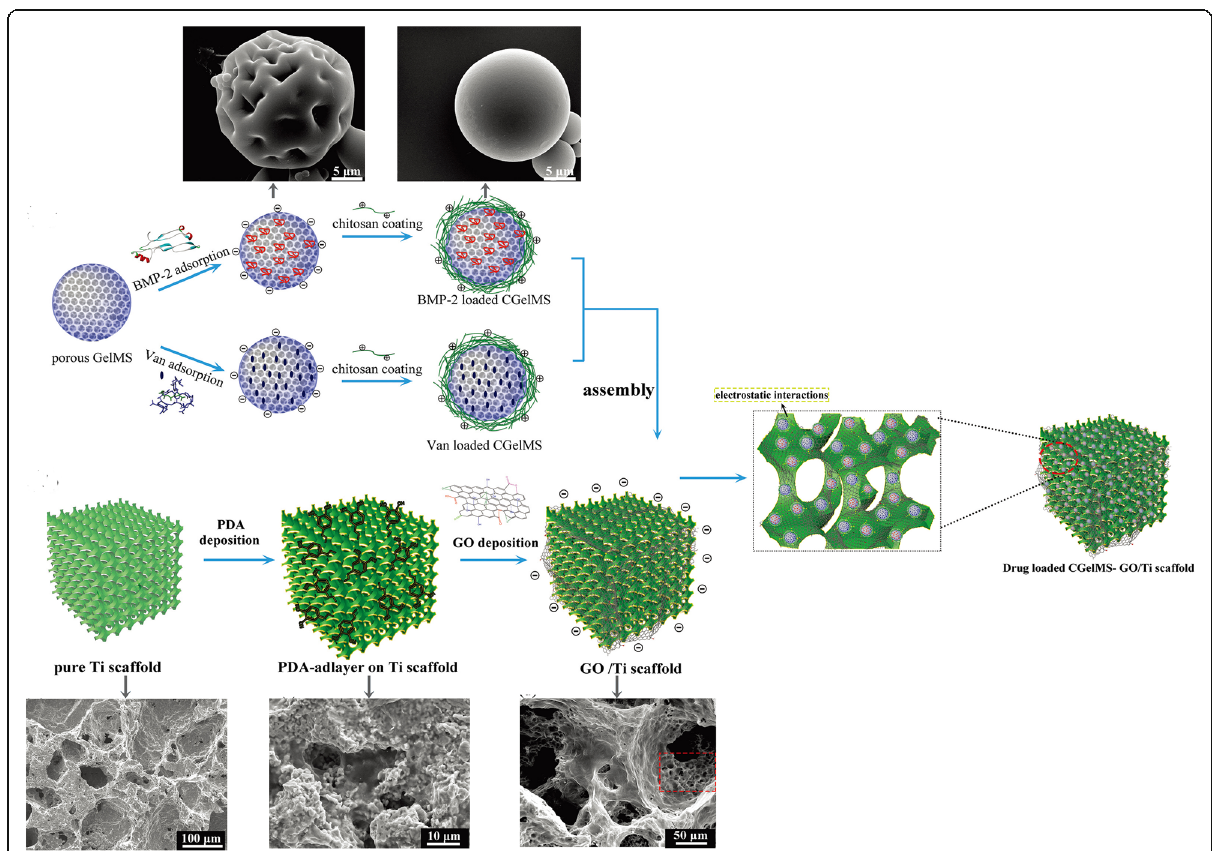
Fig. 7 Schematics and scanning electron micrographs of the preparation the new GO/Ti scaffold: BMP2- and Van-loaded CGelMS were immobilized on the GO/Ti scaffold through electrostatic interactions between the functional groups of GO and CGelMS. Reproduced from ref. [149] with permission from the Journal of Biomaterials